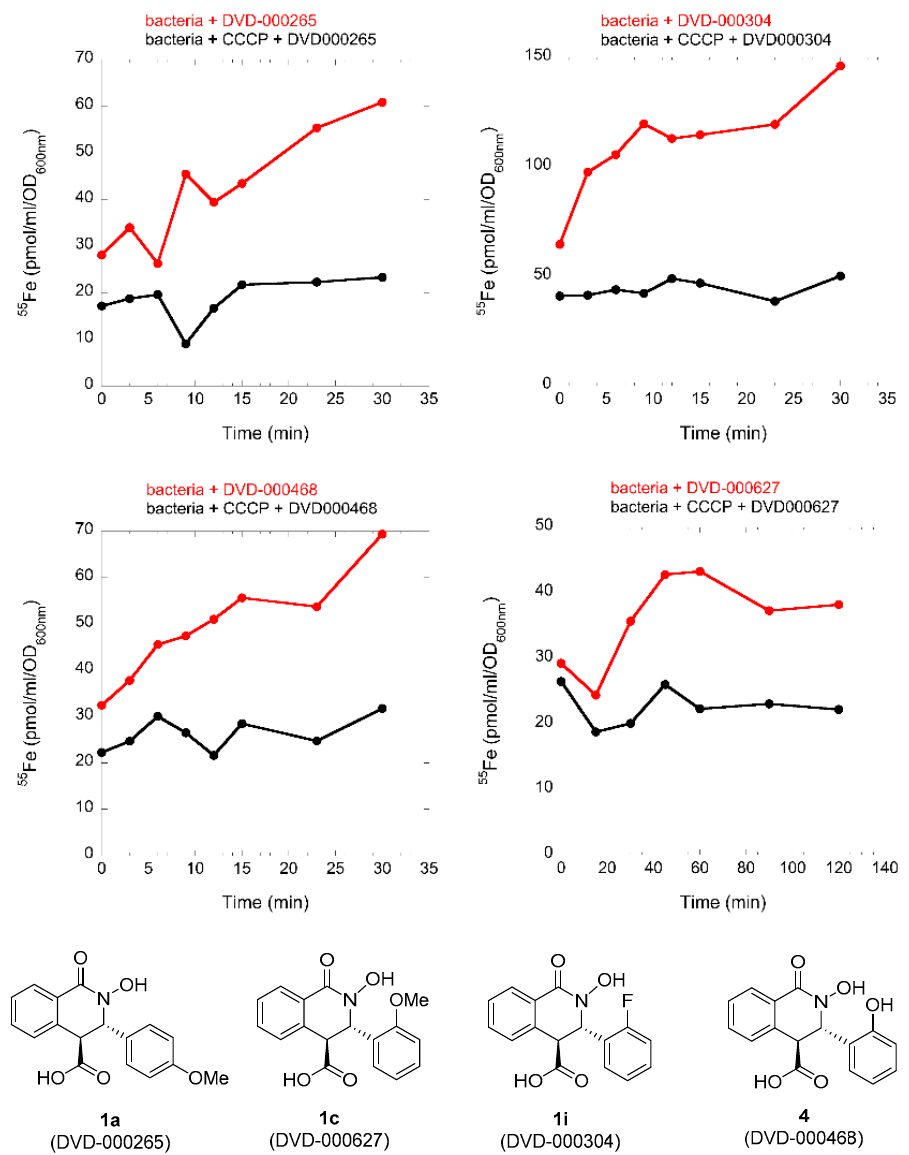
Figure 2. Transport of 55 Fe via compounds 1a (DVD-000265), 1c (DVD-00627), 1i (DVD-000304 and 4 (DVD-000468) in P. aeruginosa cells; structures of the four lead siderophores; P. aeruginosa pyoverdine and pyochelin deficient strain ( ∆ pvdF ∆ pchA ) was grown in CAA medium overnight as described in Materials and Methods. Afterwards, cells were washed with 50 mM Tris-HCl pH 8.0 and re-suspended in the same buffer to and OD 600 nm (optical density measured at 600 nm) of 1. The iron transport assay was started by the addition of 500 nM 55 Fe-loaded compounds 1a , 1c , 1i and 4 and, at different time points, aliquots were taken, bacteria were pelleted and the radioactivity retained in the cells was monitored. The ∆ pvdF ∆ pchA strain was also treated with 200 mM of CCCP protonophore and incubated in the presence of 55 Fe-loaded compounds (CCCP inhibits any proton motive dependent